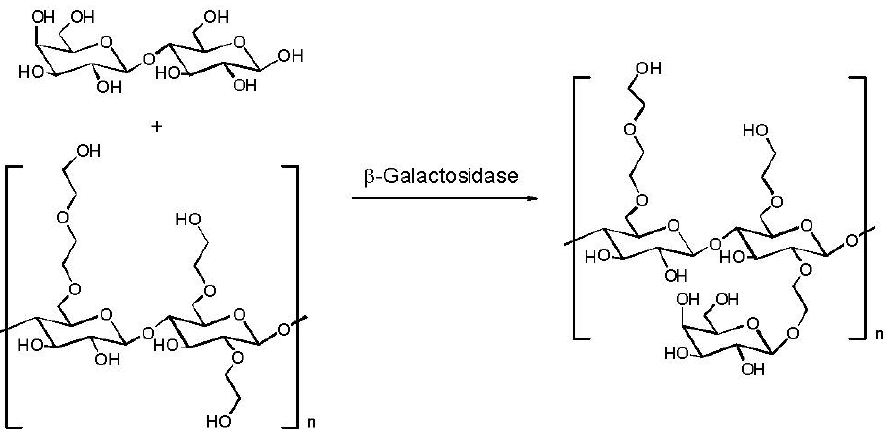
Figure 10. Glycosylation of HEC with galactose through lactose- β -galactosidase